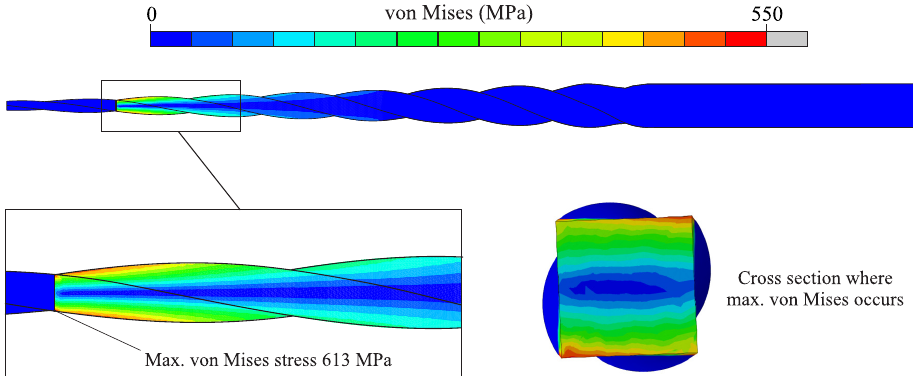
Figure 9. Stress results for bending analysis (undeformed